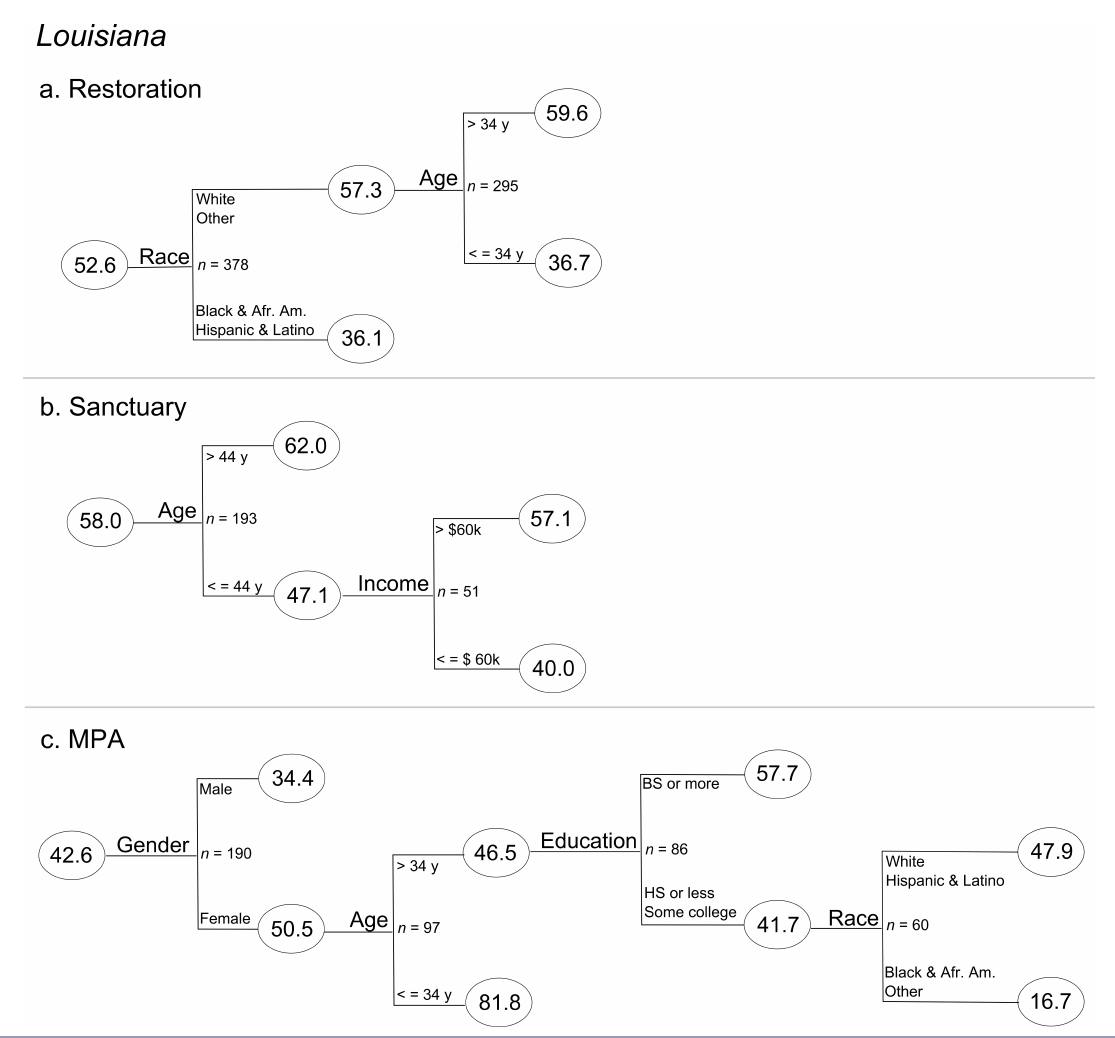
Fig. 6 . Tree showing the most powerful predictors for explaining variability among individuals who strongly support restoration (a), spawning sanctuaries (b), and MPAs as stewardship initiatives in Louisiana. The value shown within each oval is percent response for strongly support, and separate branches within the tree indicate statistical differences at P ≤